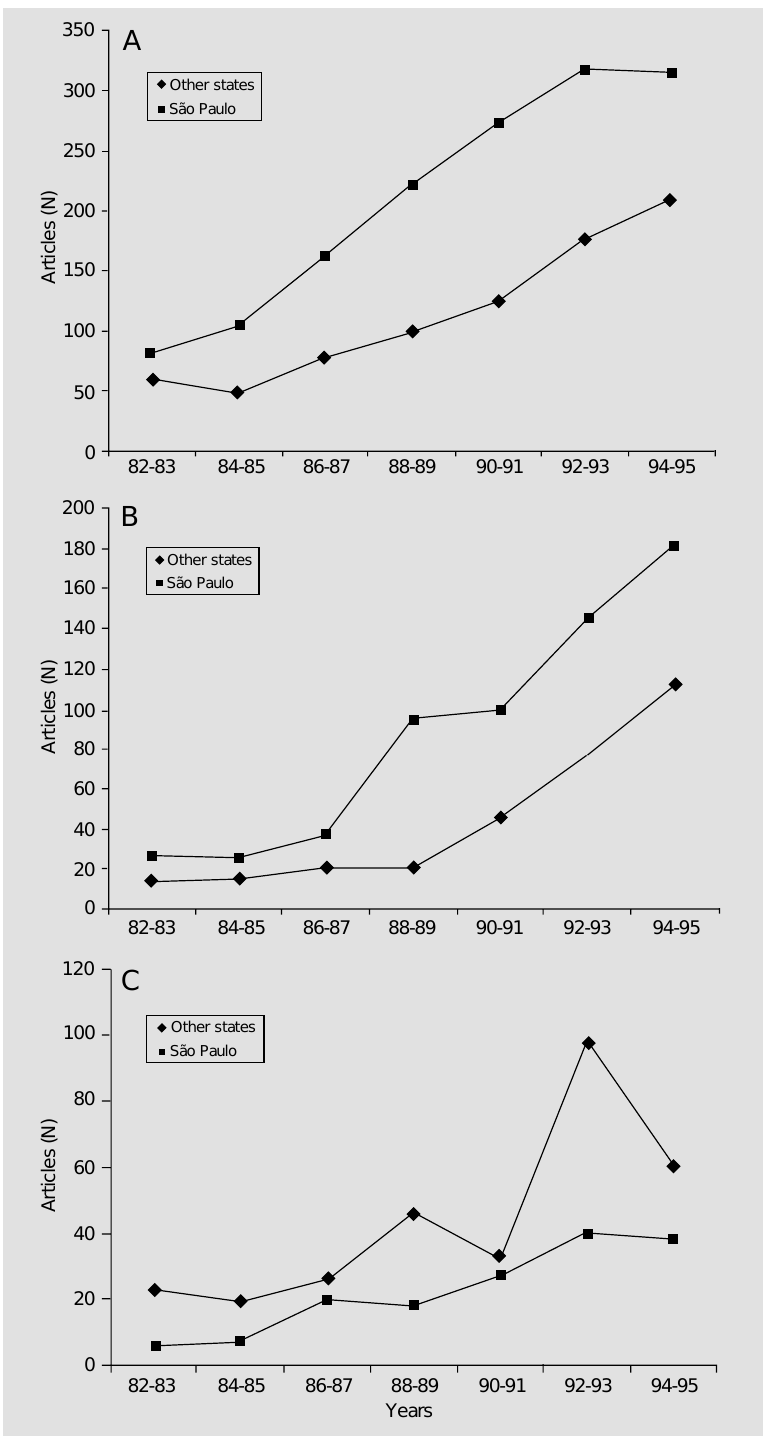
Figure 3 - Geographical distribution of scientific output trends. Values compare the number of articles with at least one address from São Paulo and the number of articles with at least one address from institutions from other states, from 82-83 to 94-95, in cancer (A), cardiovascular (B) and malaria (C) research fields. Data from both ISI and